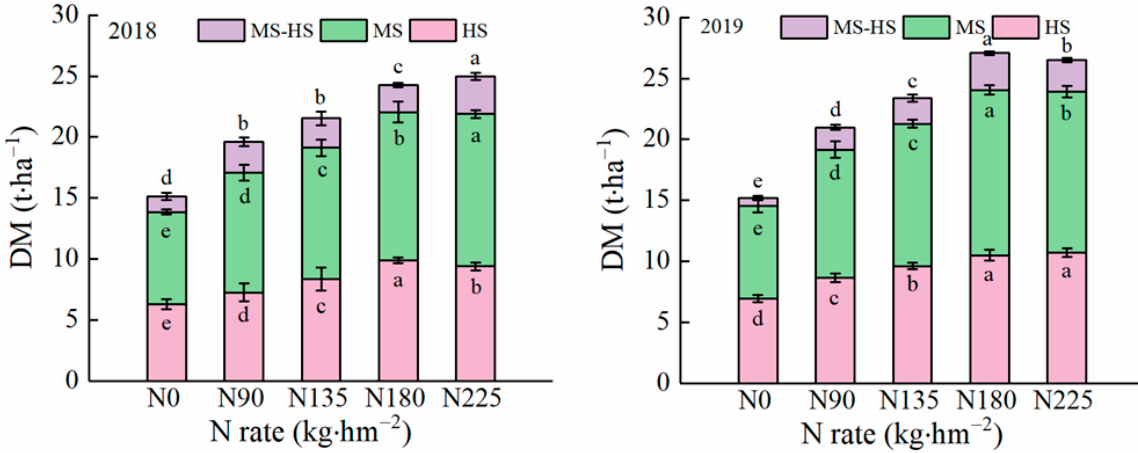
Figure 2. Effects of N application on dry matter accumulation. HS represents heading stage; MS represents mature stage, lower case letters indicate that the physical and chemical properties of the low-gluten rice are significantly different with the different treatments ( p < 0.05, LSD method).